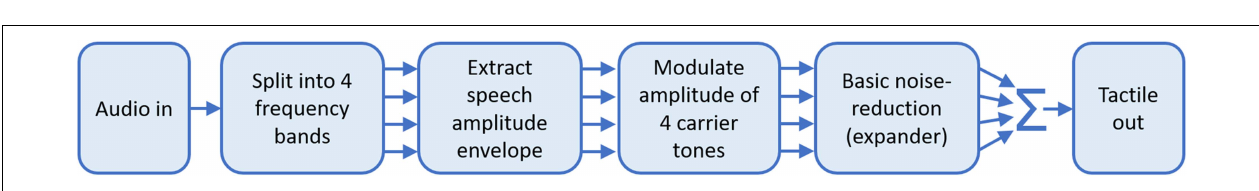
FIGURE 2 | Block diagram describing the haptic signal-processing strategy used by Fletcher et al.